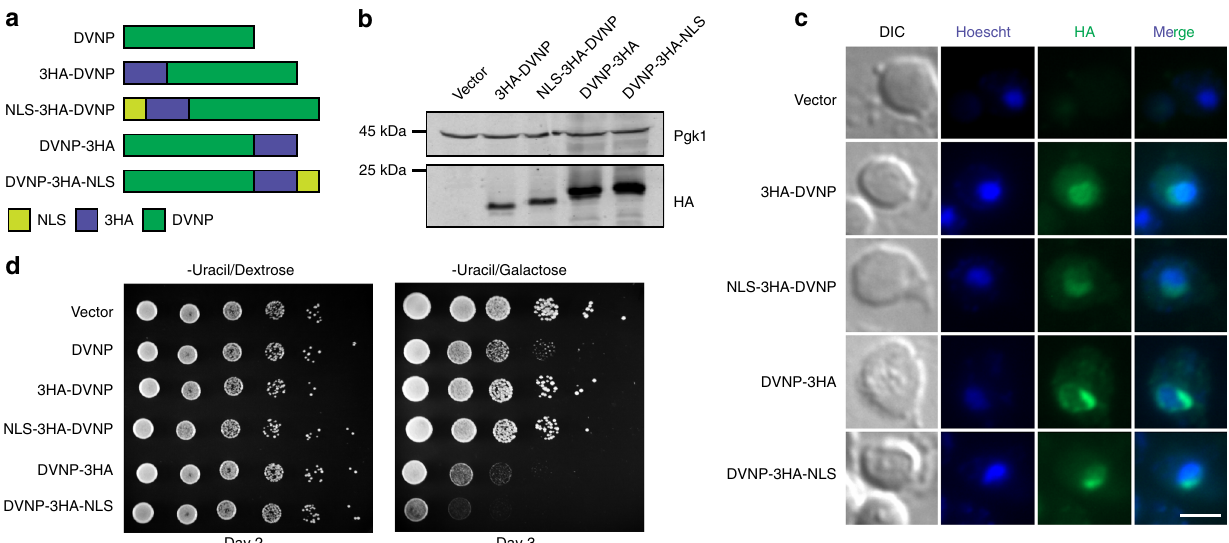
Fig. 1 DVNP is localized to the nucleus and impairs growth in S. cerevisiae . a Schematics of DVNP constructs. b Immunoblot of total protein extracts from galactose-induced cells. c Immuno fl uorescence micrographs showing colocalization between the HA epitopes on DVNP (green) and Hoescht stain (blue). Scale bar, 3 μ m. This experiment was repeated twice with the same results. d Serial dilution growth assays for cells containing indicated expression constructs. Cells were grown on selective media lacking uracil in the presence of either dextrose or